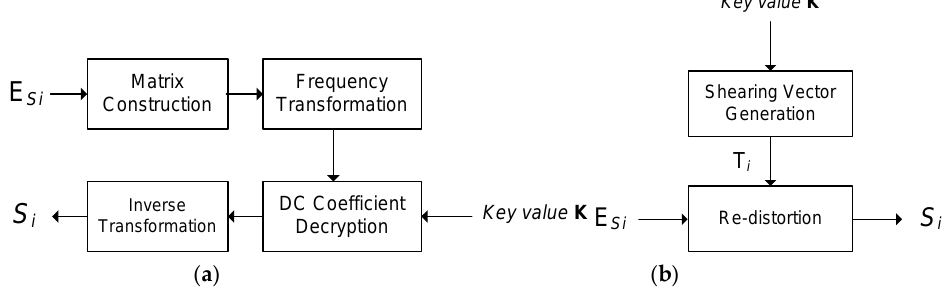
Figure 8. ( a ) Decryption in the frequency domain, and ( b ) Decryption in the spatial domain.